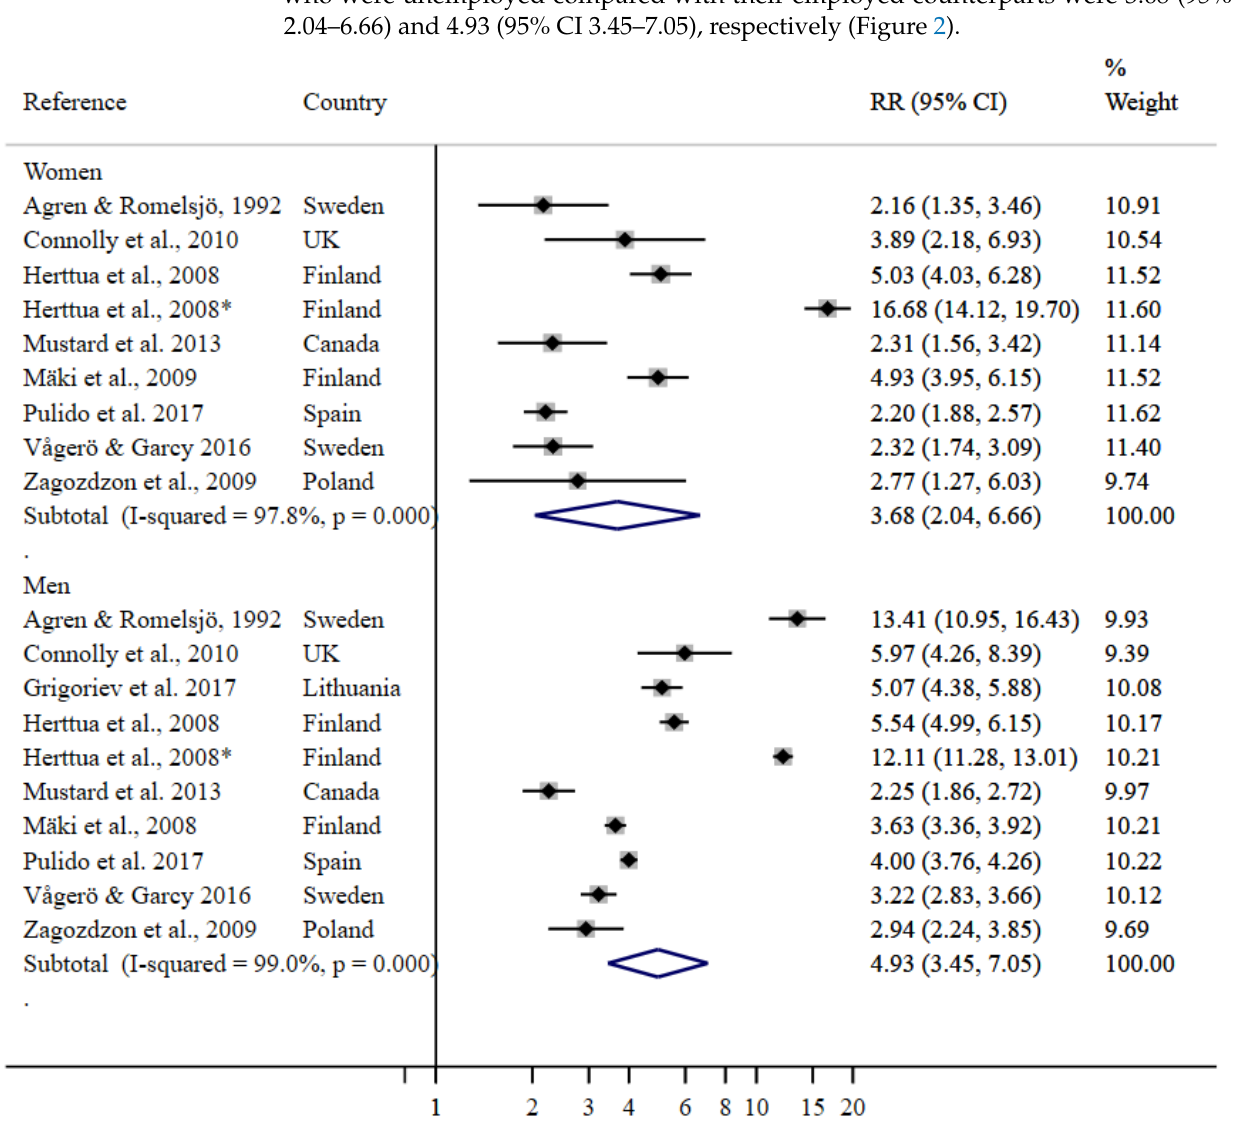
Figure 2. Random-effects meta-regression for employment status. RR, relative risk; CI, confidence interval; UK, United Kingdom. * This estimate is referring to long-term unemployment, whereas the other estimate by Herttua et al. 2008 [20] is referring to short-term unemployment. For women refer to [19,20,32,35–39], for men refer to [19,20,32–34,36–39]. Herttua et al. 2008 [20] used short- and long-term unemployment as two levels of unemployment, both of which were included in the meta-analysis. Among both